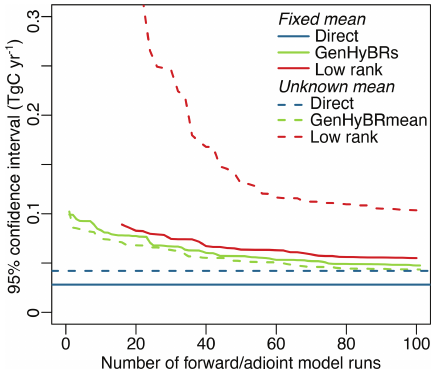
Figure 5. Estimated uncertainties for the total CO 2 flux from the continental US over the 6-week case study (50% noise levels). The figure compares posterior uncertainties calculated using the direct approach, using GenHyBR and using the low-rank approach de- scribed in Miller et al. (2020). Solid lines show uncertainties es- timated for simulations with a fixed mean and dashed lines simu- lations with an unknown mean. In addition, we use the same reg- ularization parameter ( λ ) for the estimates shown here to make the convergence behavior of the different approaches easier to compare ( λ = 0 . 13 for the fixed mean and λ = 0 . 15 for the unknown mean, as in Table 2). GenHyBR reaches uncertainty estimates that are close to the direct estimate more quickly than the low-rank approach, par- ticularly for the unknown mean case. In addition, GenHyBR uses forward and adjoint model runs previously generated as part of the best estimate calculations, yielding large computational savings over the low-rank approach, which requires new model runs.